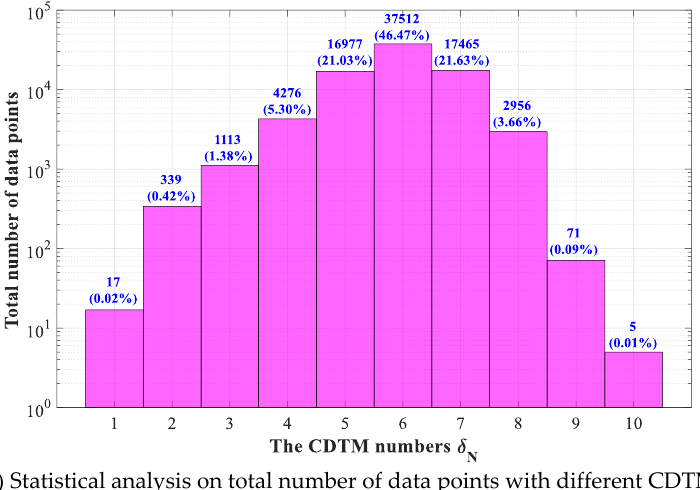
Figure 13. The pre-processed point cloud data and their modified Delaunay triangular meshes.